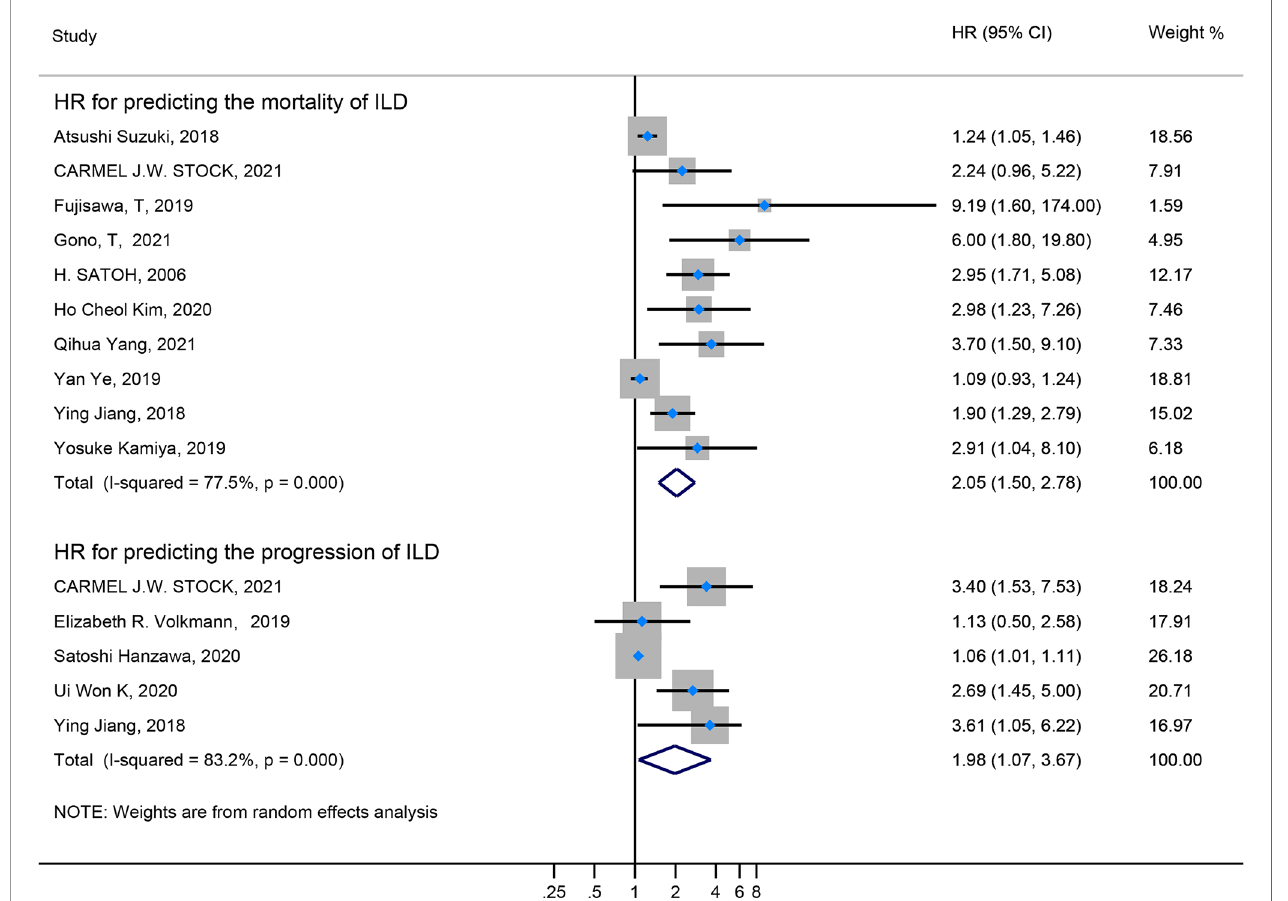
FIGURE 5 | The forest plot illustrated the HR (95%CI) of elevated KL-6 level predicting the progression/mortality of